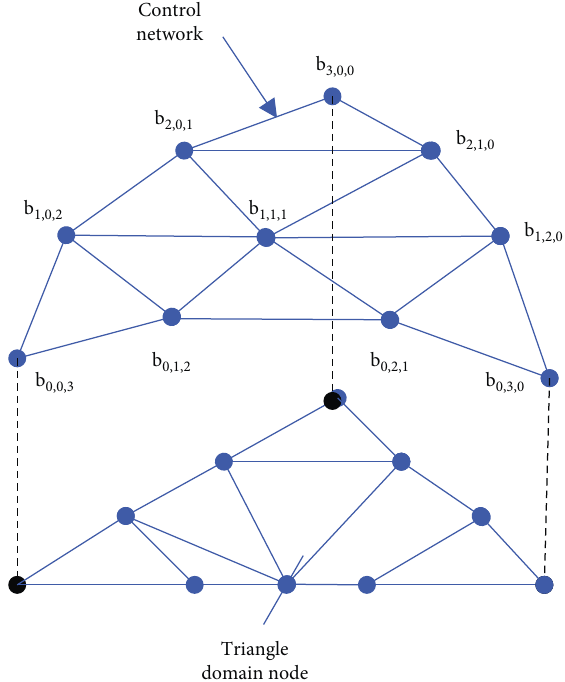
Figure 3: The cubic triangular B–B surface control vertex and triangular parameter domain